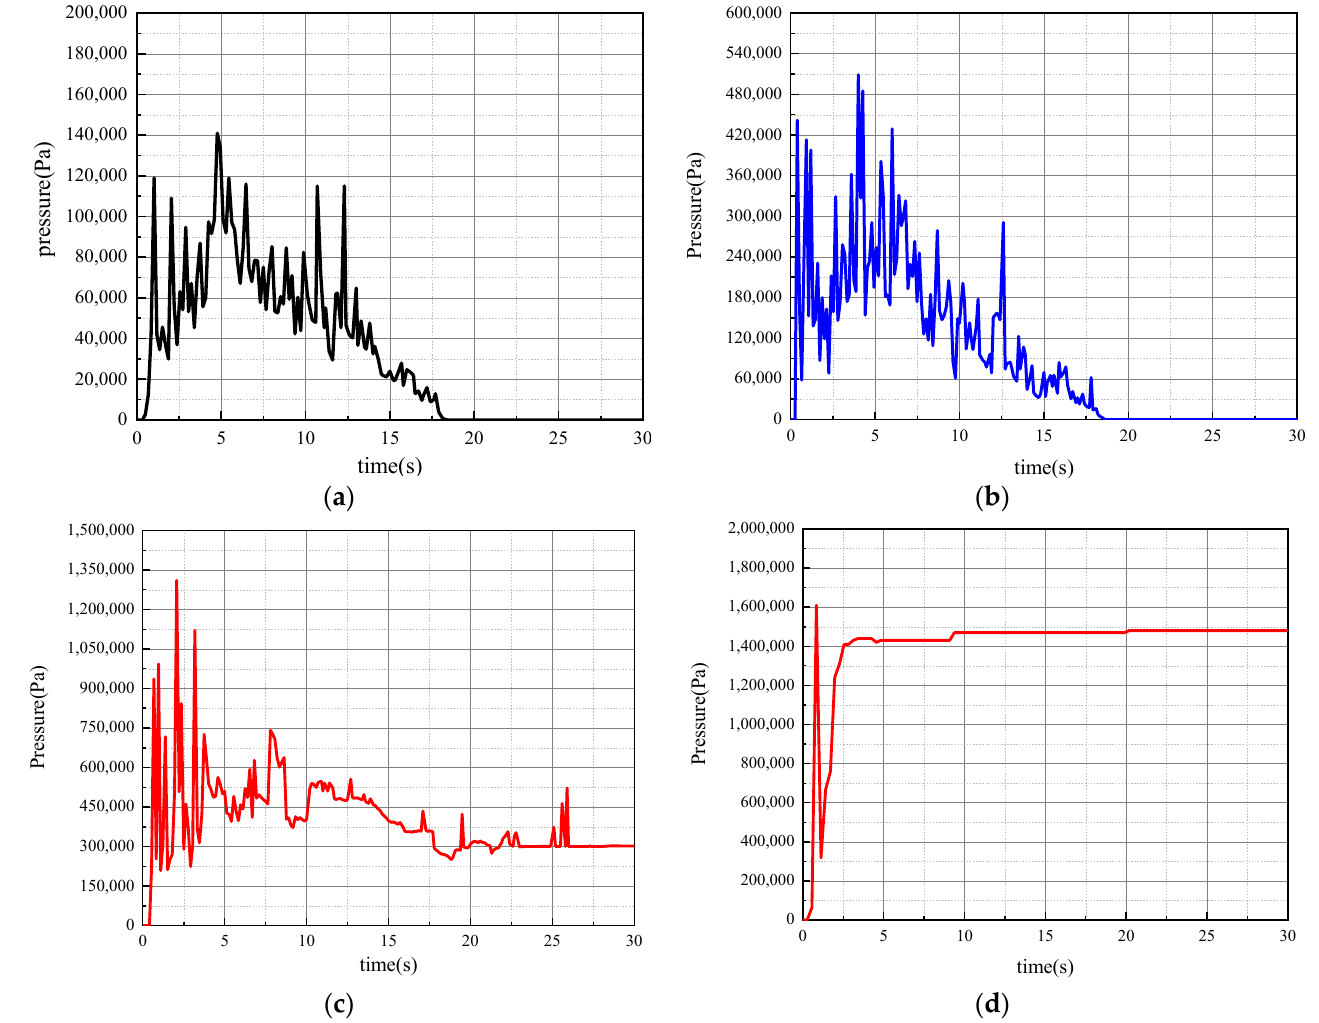
Figure 14. Maximum pressure variation on the guide vane of the first stage pump with different particle sizes: ( a ) 10–20 mm; ( b ) 20–30 mm; ( c ) 30–40 mm; ( d ) 40–50 mm.